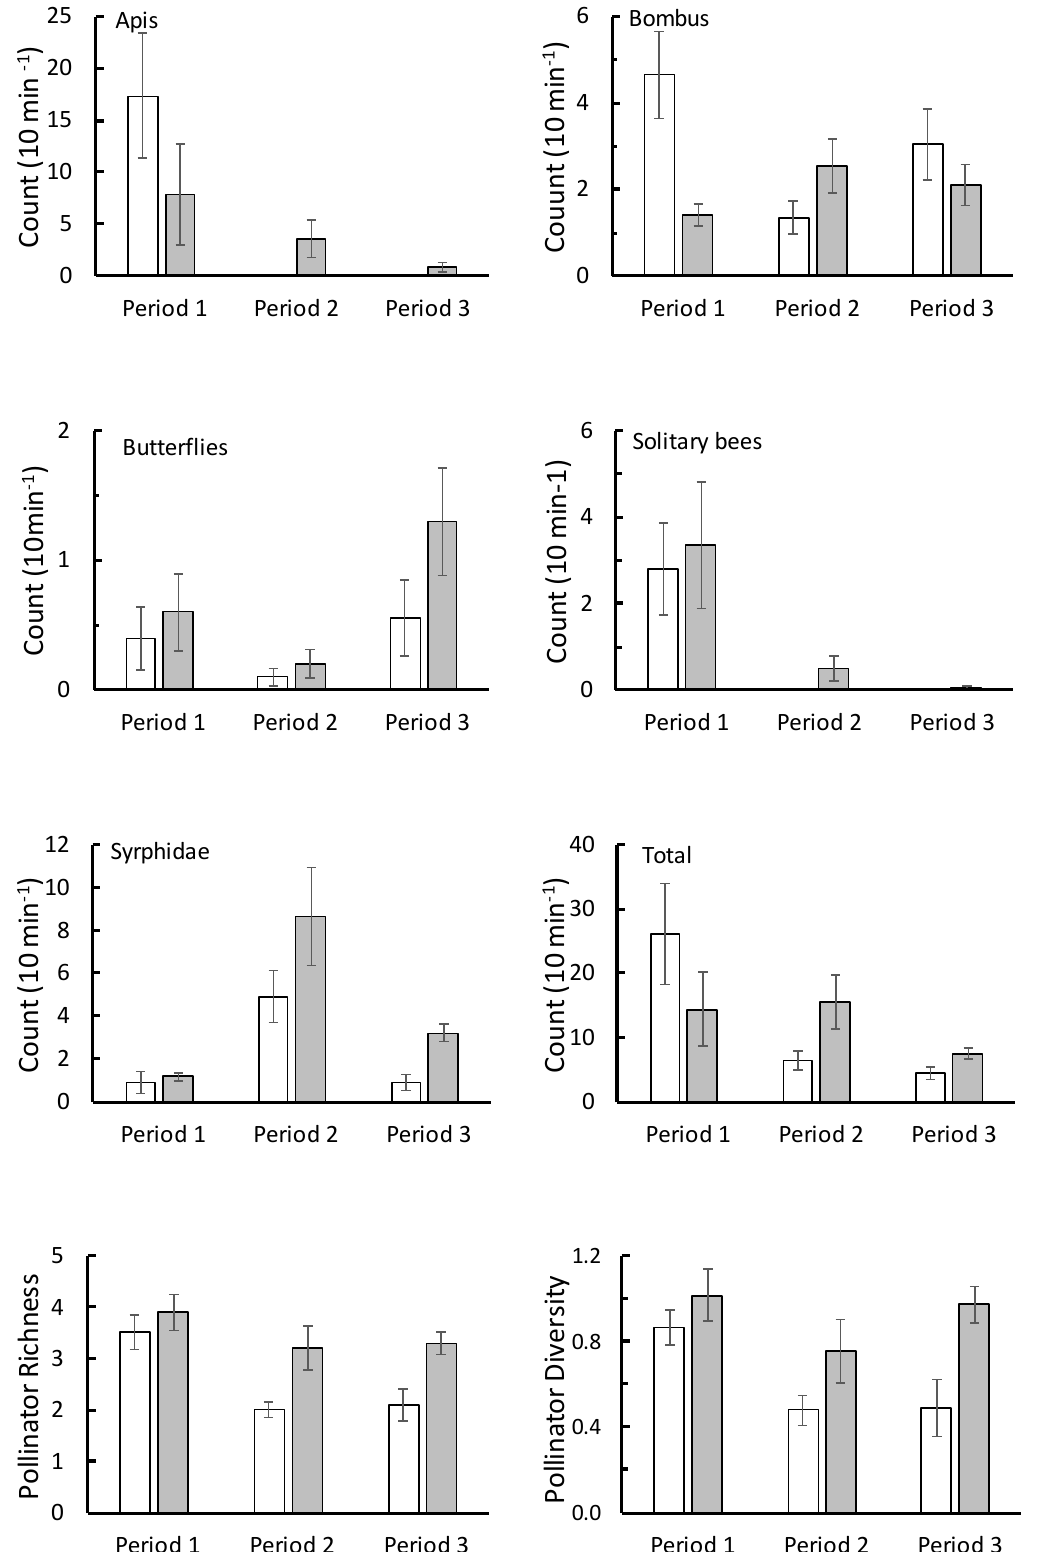
Figure 3. Abundance (mean ± SE) and diversity of pollinating insects in the centre of the crop (white columns) and field margins (grey columns) of apple orchards ( n = 5) during (Period 1), 1-month after (Period 2) and 3-months after flowering (Period 3) of the main